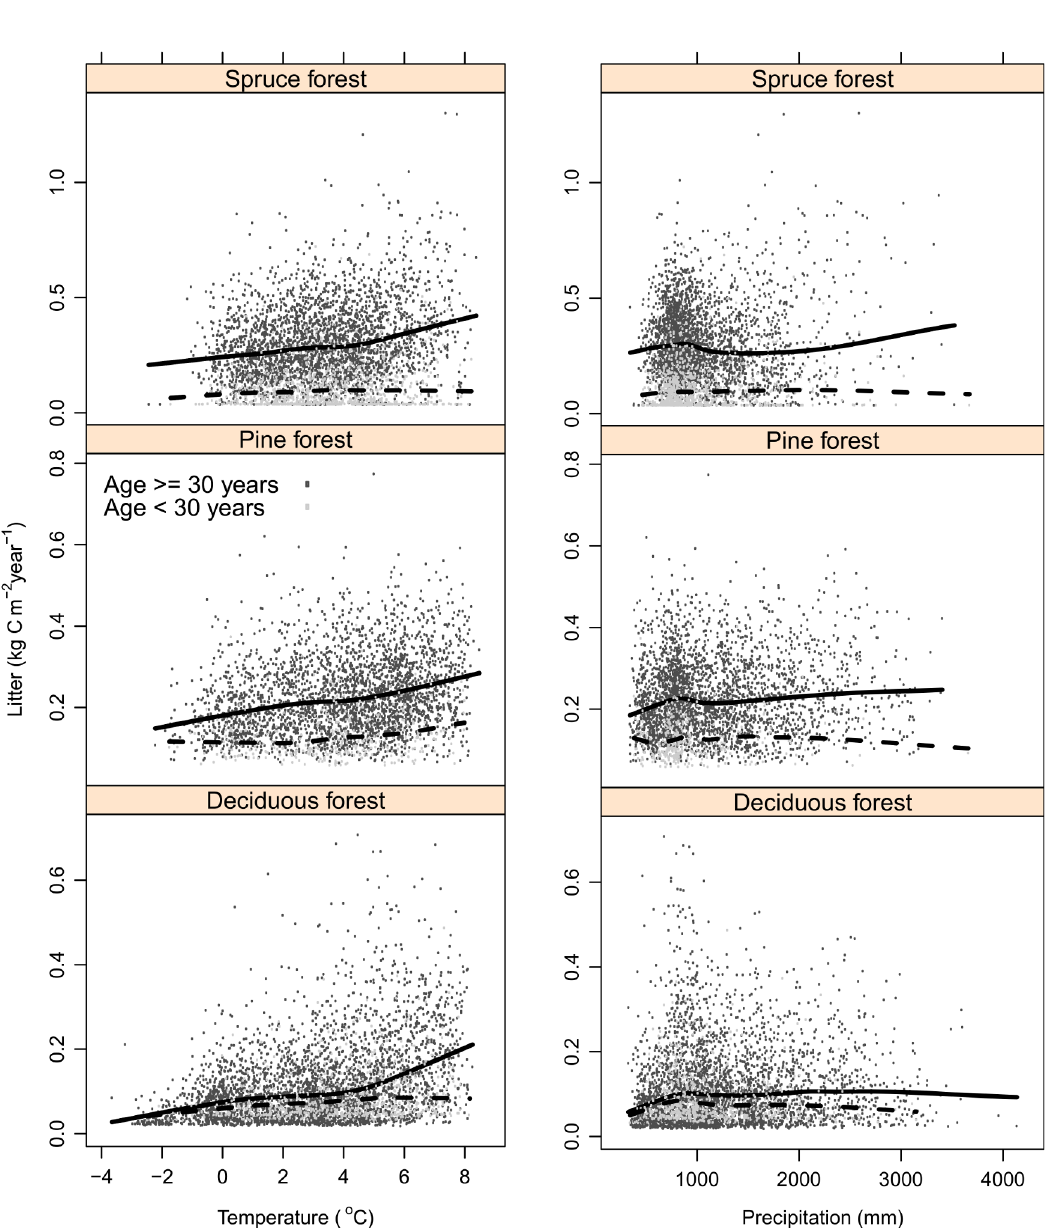
mean. Vertical lines (figure parts C and D) indicate distribution of districts to regions southeast (SE), southwest (SW) and north (N) (see Fig 1). (A) Mean of estimated soil carbon (soil C) stocks (2008 to 2012) was highest when constant mean climate was applied. (B) Soil carbon change estimates scaled to the national level. Simulations with constant climate showed higher change rates than those using a higher temporal resolution. (C) District means of estimated soil carbon stocks (2008 to 2012) were consistently higher when constant climate was used. (D) District means of estimated soil carbon stock changes (2000 to 2012) were consistently higher when constant climate was applied. Substantial differences across aggregation levels emerged particularly in the southeastern and in some northern districts.